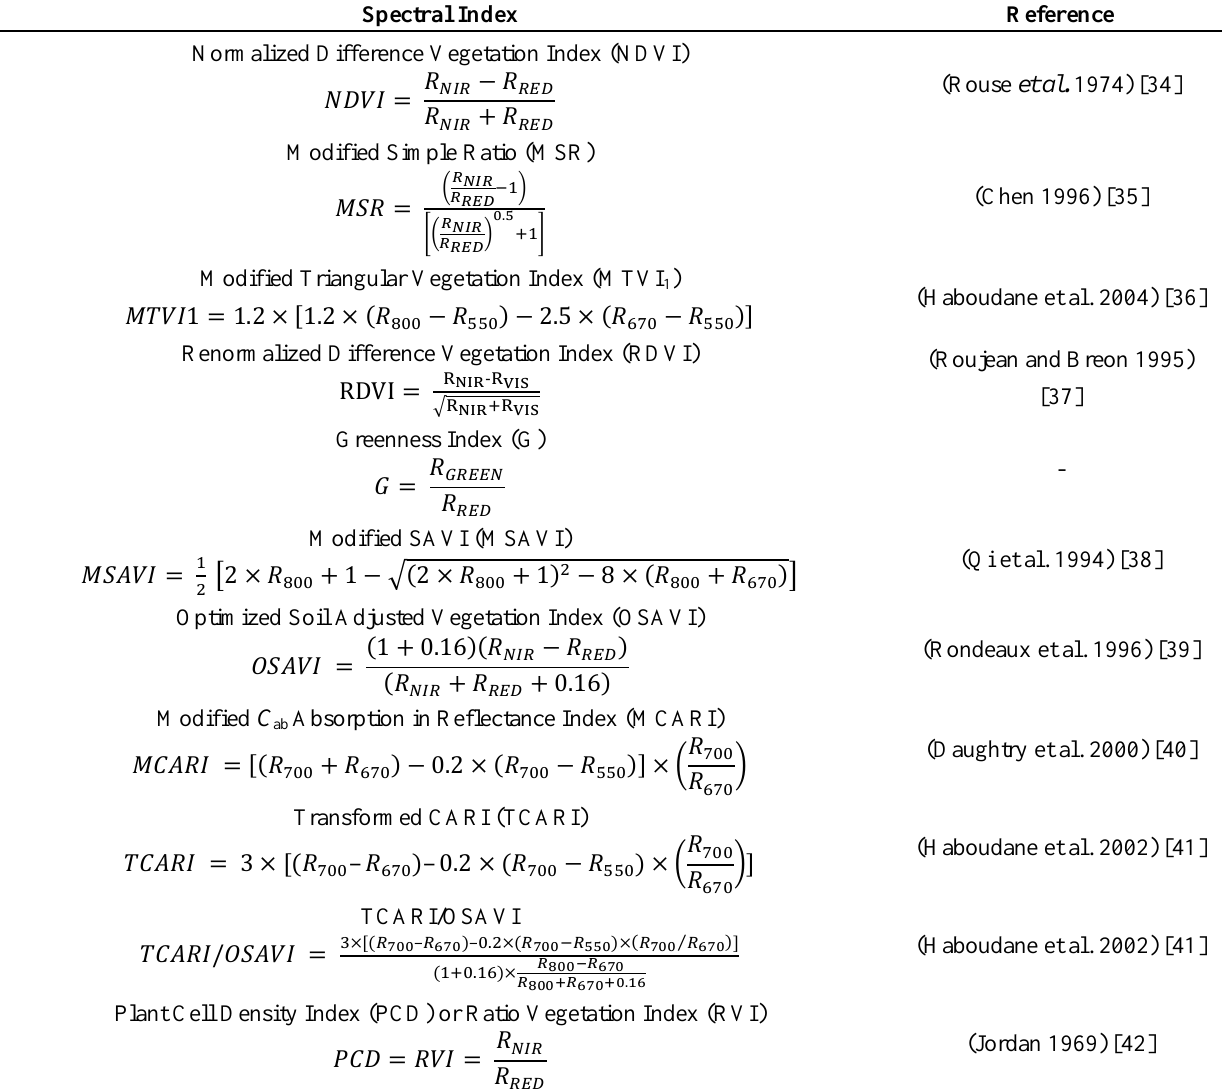
Table 1. Spectral vegetation indices commonly used in viticulture